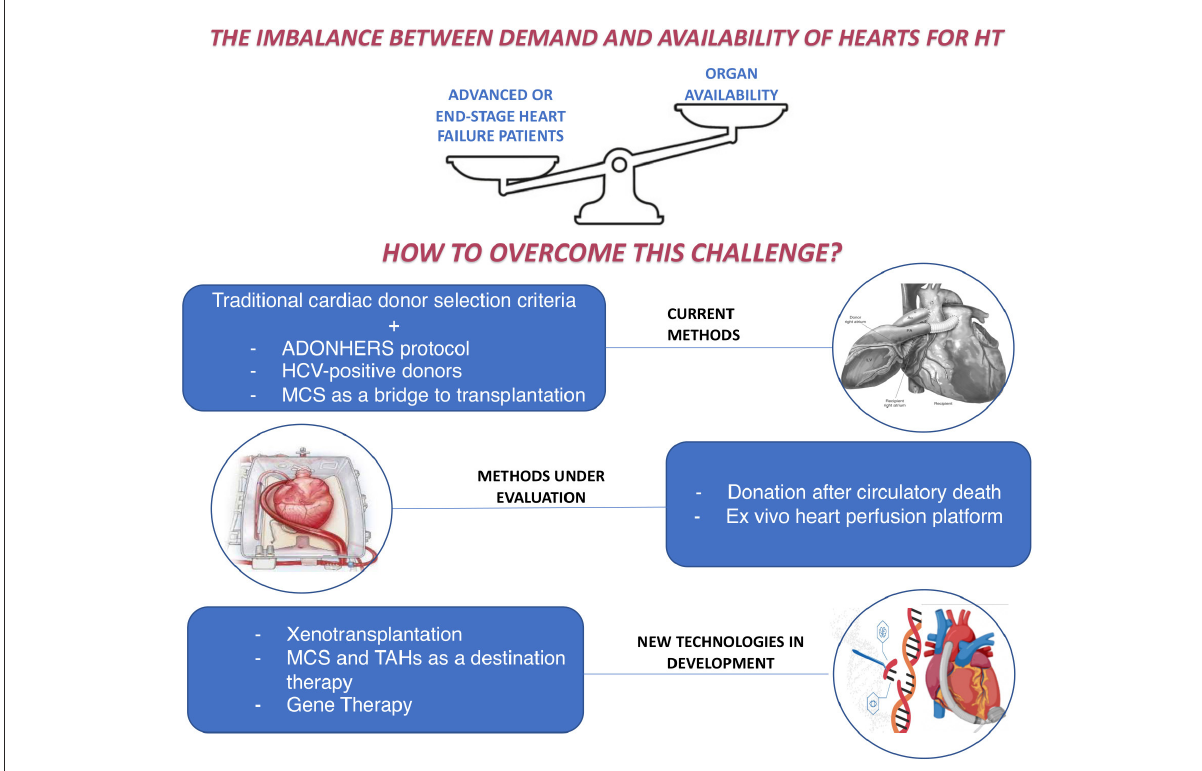
FIGURE2 How to overcome the imbalance between demand and availability of hearts for heart transplantation: current methods and new perspectives. ADONHERS, aged donor heart rescue by stress-echo; HCV, Hepatitis C virus; HT, Heart Transplantation; MCS, mechanical circulatory support; TAHs, Total artificial